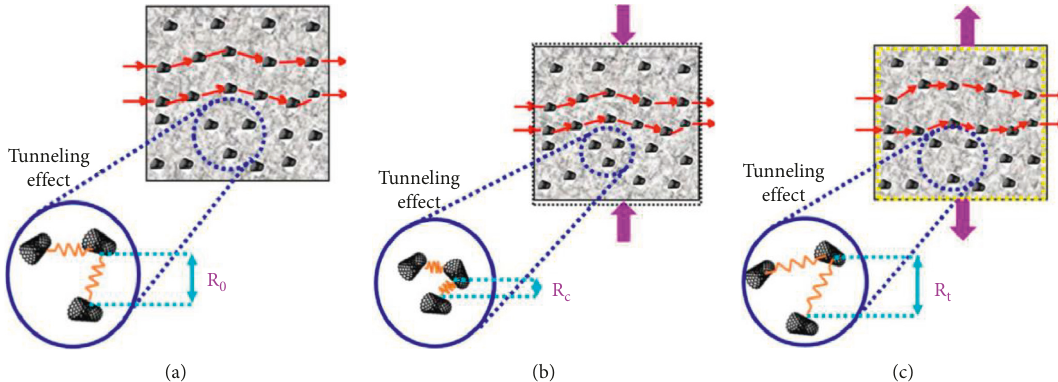
Figure 19: Schematic for the effect of tunnelling on the resistance: (a) initial condition, (b) during compression loading, and (c) during tensile loading [26].